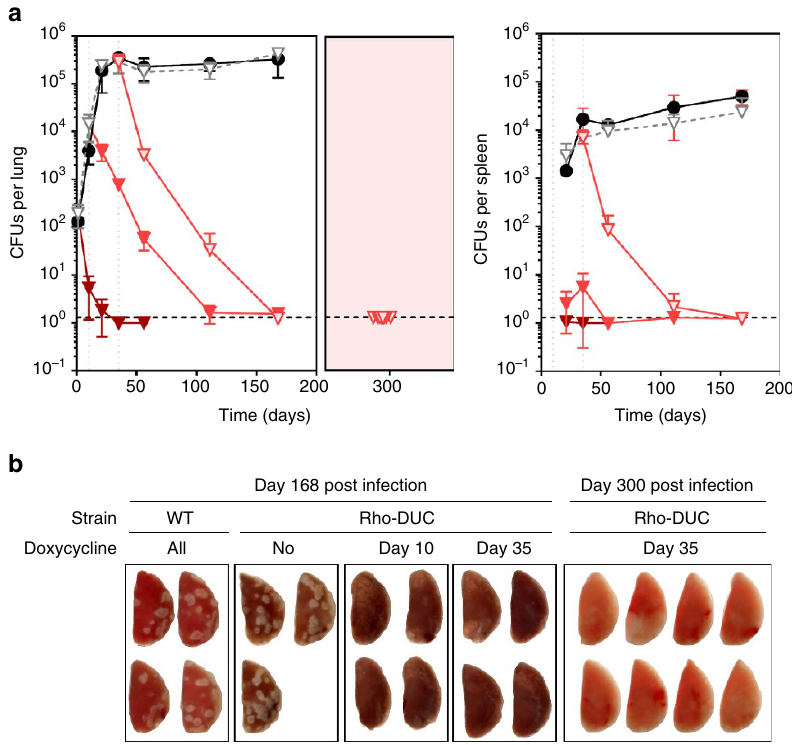
Figure 6 | Depletion of Rho kills M. tuberculosis in mice. CFU isolated from lungs and spleens of mice infected by WTor Rho-DUC ( a ). The mice infected by the mutant received regular food for the whole duration of the experiment (open grey triangles), or were given food supplemented with doxycycline starting before the infection (dark brown triangles), at day 10 post infection (red triangles) or at day 35 post infection (light pink triangles). The mice infected by the WT Mtb strain received doxycycline-supplemented food for the whole duration of the experiment (black circles). In the pink insert mice that were infected with Rho-DUC received doxycycline-supplemented food from day 35 to day 200, and received doxycycline-free food from day 200 to 300. Data are averages ( ± s.d.) from 3–8 mice as indicated in ( b ), the dashed line represents the limit of detection of 1.3 CFUs per lung or per spleen. ( b ) Lungs collected at day 168 and day 300 post infection from mice infected with the indicated